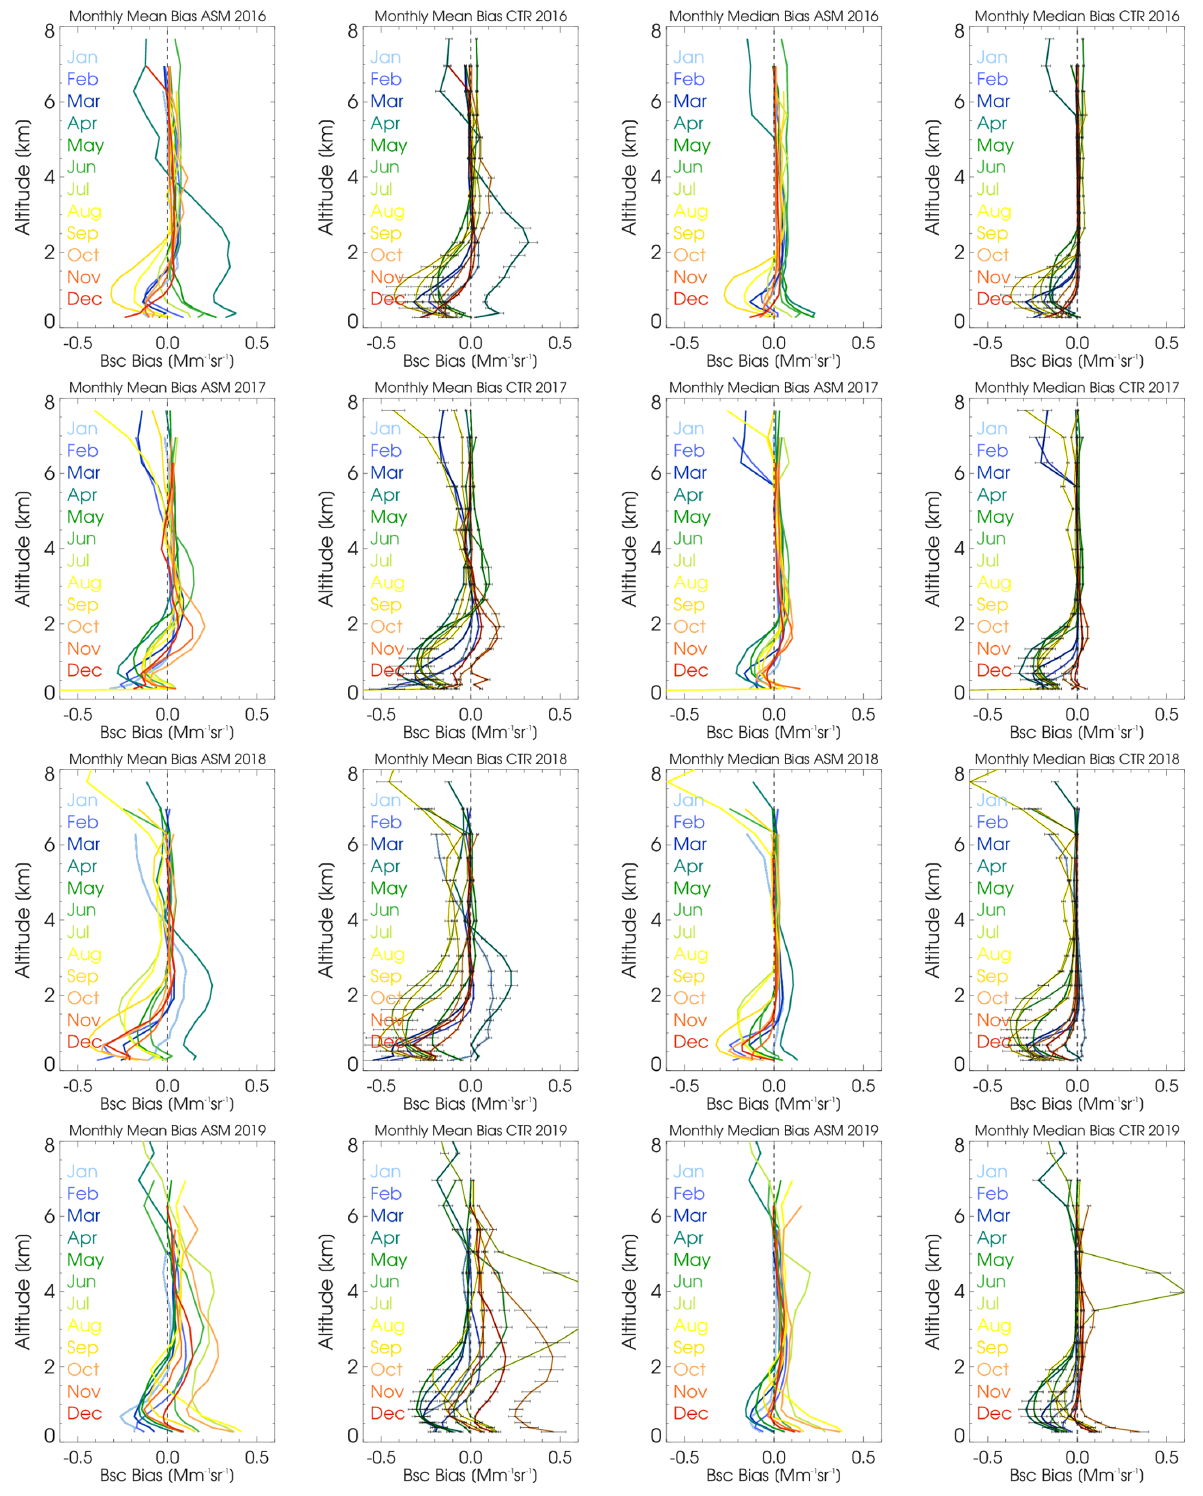
Figure 3. Monthly mean (left pair) and median (right pair) profiles of bias ASM/ceilometer (left) and CTR/ceilometer (right), combined from 21 German stations in 2016–2019. At higher altitudes, the profiles are partly contaminated by remaining cloud